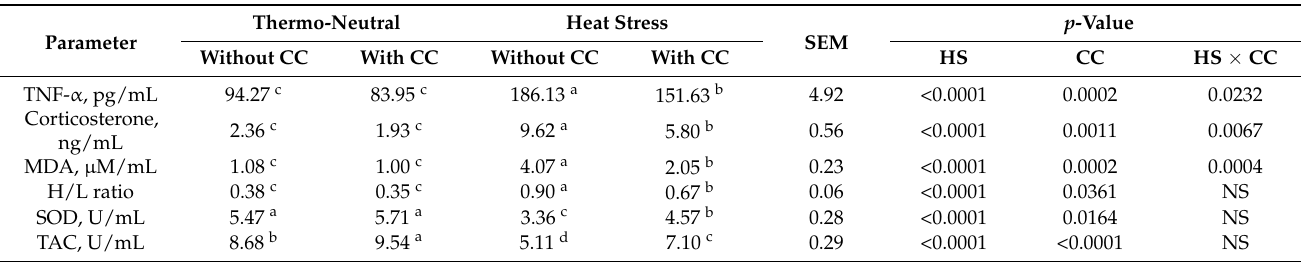
Means in the same row with different superscripts significantly differ ( p < 0.05). CC, Citrullus colocynthis ; TNF- α , tumor-necrosis factor alpha; MDA, malondialdehyde; H/L, heterophils: lymphocytes ratio; SOD, superoxide dismutase; TAC, total antioxidant capacity. The HSP-70 Western blot output of broilers subjected to either thermo-neutral or heat-stress conditions and with or without CCs supplementation is presented in Figure 1.